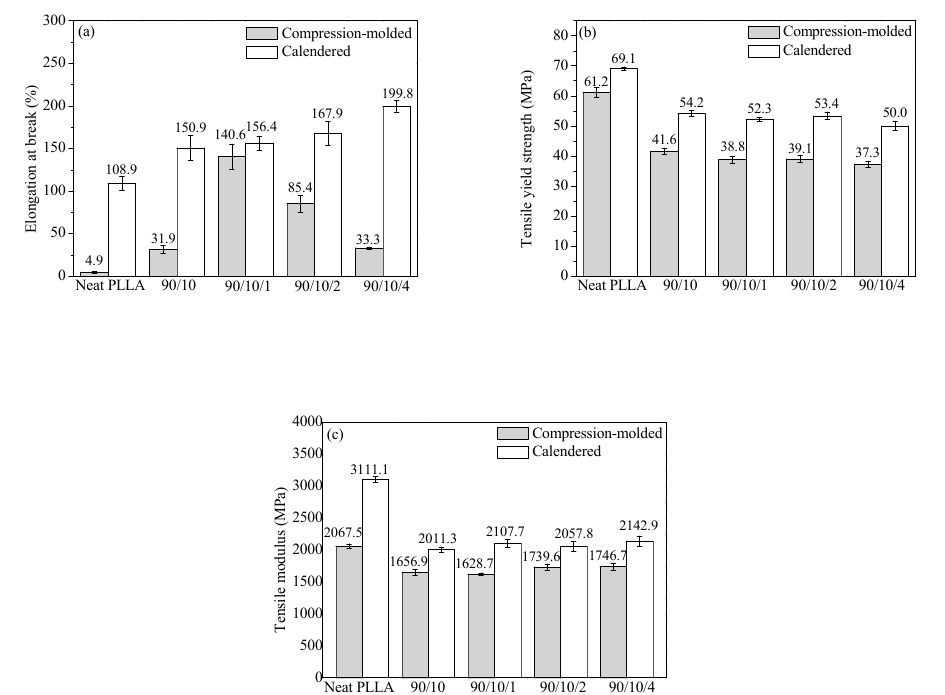
Figure 2. ( a ) elongation at break, ( b ) tensile yield strength, and ( c ) tensile modulus of PLLA and PLLA/EPDM/OMMT (90/10/ x ) samples prepared by compression-molding and